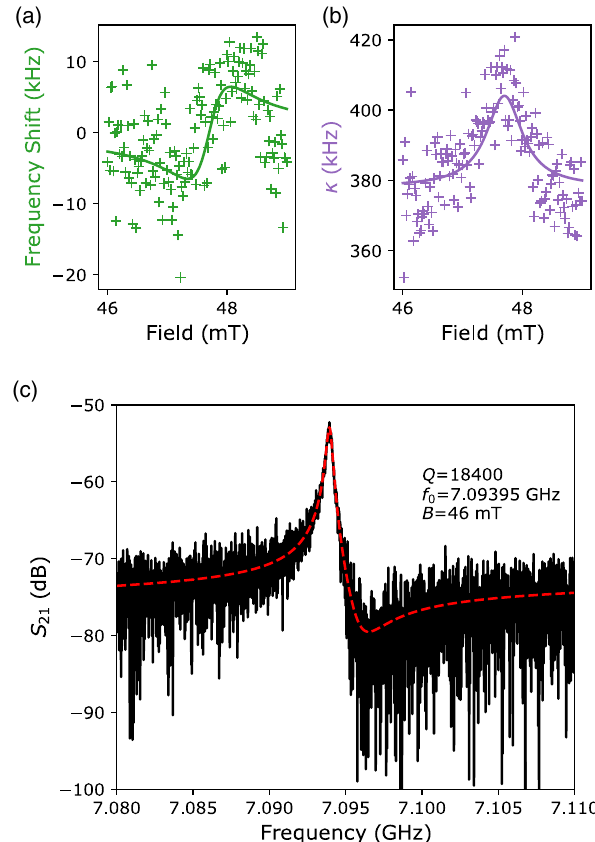
FIG. 9. Effect of spins on (a) resonator frequency and (b) res- onator linewidth κ as a function of magnetic field as the spin line passes through the resonator. Data are fit simultaneously to ∼ 120 kHz and γ ∼ 2 . 4 MHz. equations in Ref. [52] g ens (c) Measurement of transmission magnitude through the copper cavity using a VNA at 46 mT (off resonance with spin line). The superconducting resonator gives a characteristic Fano resonance response which we fit to extract a center frequency for this resonator of 7.093 95 GHz and a Q factor of 18